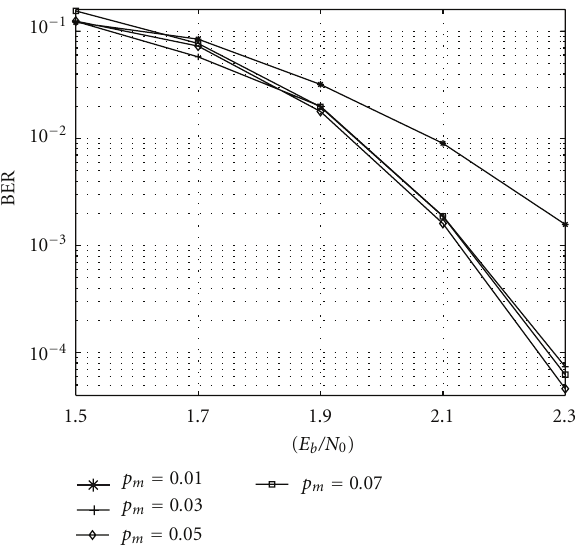
Figure 8: E ff ect of the mutation rate for (16, 11, 4) 3 3D-PBC at 12th iteration on IGAD1.